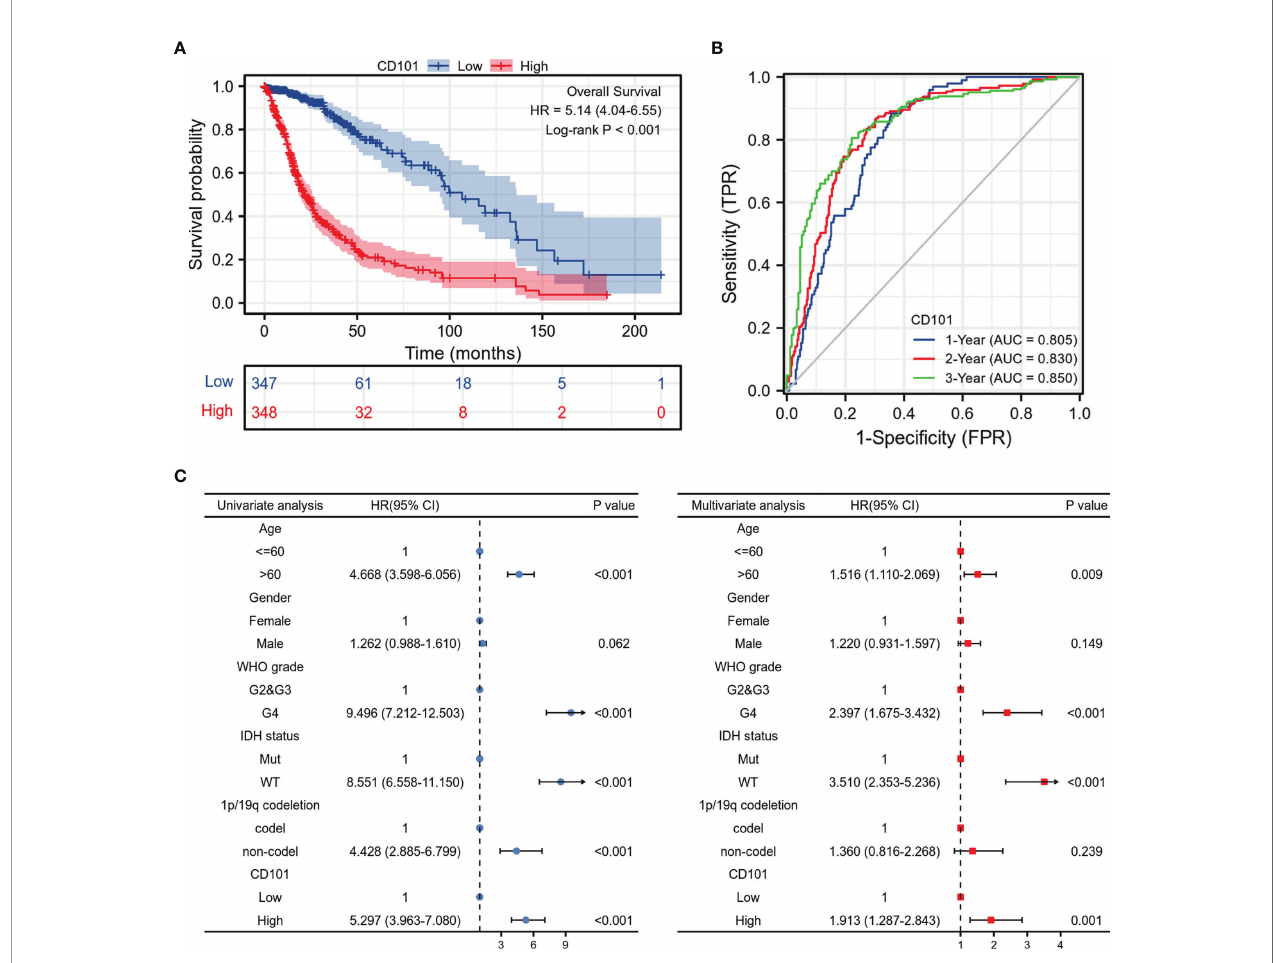
FIGURE 3 | Prognostic value of the CD101 expression level in TCGA database. (A) Survival curves using the TCGA database are shown for OS. (B) Time- dependent curves for CD101 expression in glioma using TCGA database. (C) Forest plot of univariate and multivariate Cox regression analysis in